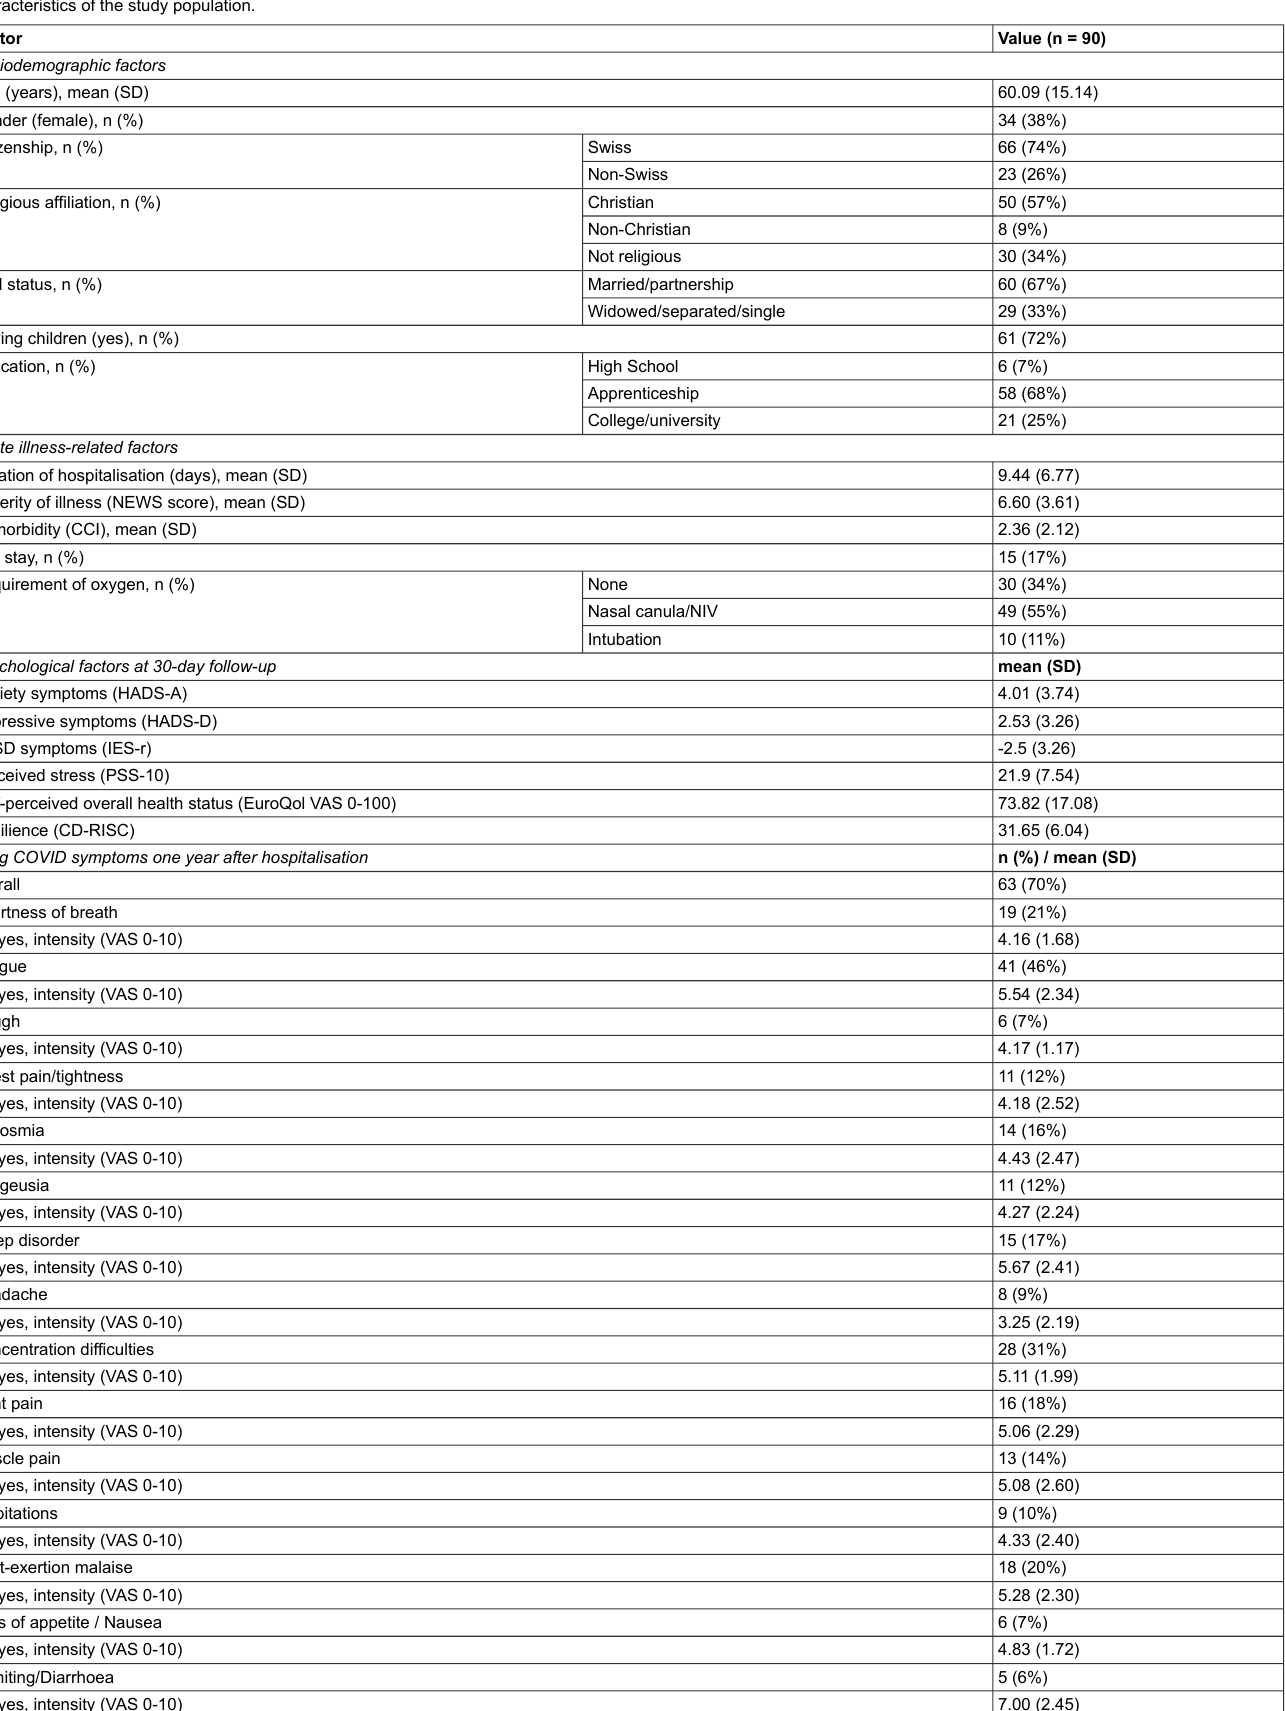
Table 1: Characteristics of the study